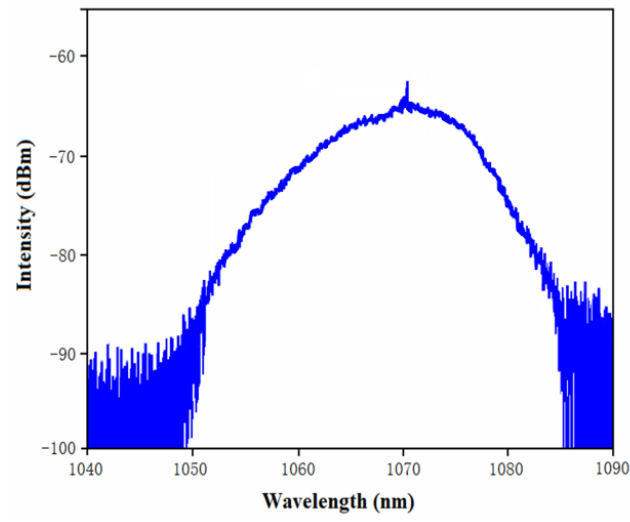
Figure 2. Spectrum of ASE super-fluorescence seed. When the pump power was 245 W, the pre-amplifier output power was about 128 W. To maintain the stability of the amplification spectrum, the low-power 5 W pump source was used in the first stage of amplification. In the three-stage pre-amplification spectrum, with increases in pump power and output power, the central wavelength appeared to display a red-shift (frequency-shift) phenomenon, as shown in Figure 3. This phenomenon also appeared in the power amplification stage (main stage amplification). Interestingly, during each stage of pre-amplification, we also discovered that the FWHM was gradually reduced from 25 nm to 13 nm, and the FWHM was reduced to 3.7 nm at the power amplification stage (main stage amplification). The central wavelength and FWHM versus different output powers were altered as shown in Figure 4. With increasing output power, the central wavelength kept shifting and increasing. After the power increased to 1.73 kW, the central wavelength tended to be stable, and the FWHM tended to decrease with increasing output power. In the output process of the power amplification stage (main stage amplification), the FWHM showed a relatively stable state.